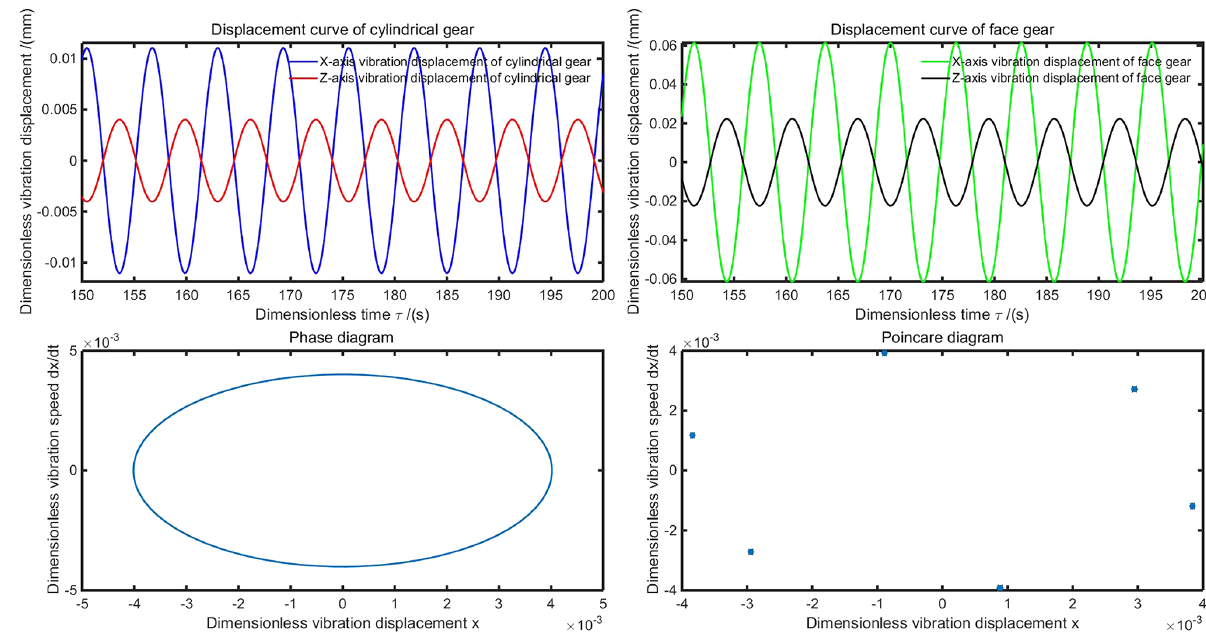
Figure 5. Displacement, phase, and Poincare diagrams of 2nd stage face gear pair.